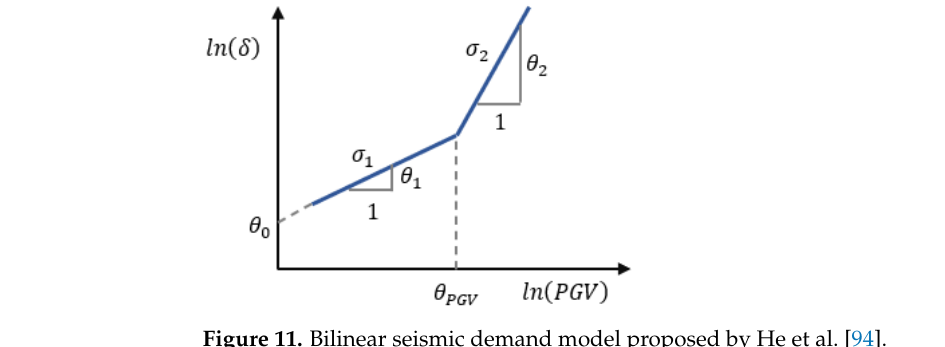
Figure 11. Bilinear seismic demand model proposed by He et al. [94]. Table 4. Studies on seismic fragility assessment of cut and cover tunnels/subway stations/rectangular underground structures subjected to ground seismic shaking in the transversal